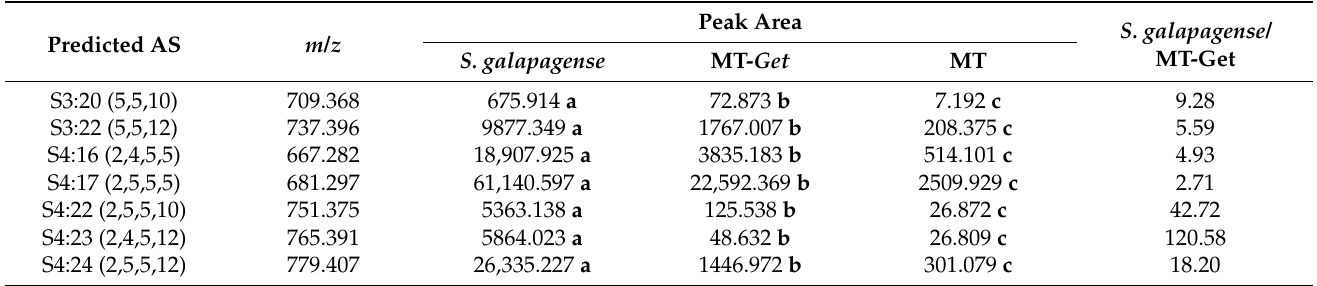
Table 1. Peak areas from ion chromatograms (LC-MS/MS) of acylsugars from S. galapagense , MT- Get , and MT.